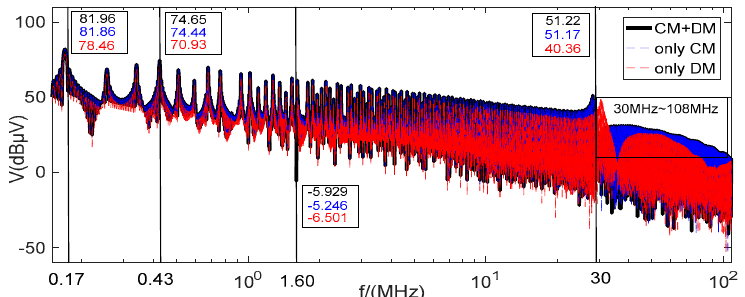
Figure 17. The conducted voltage measured on line impedance stabilization networks (LISNs).